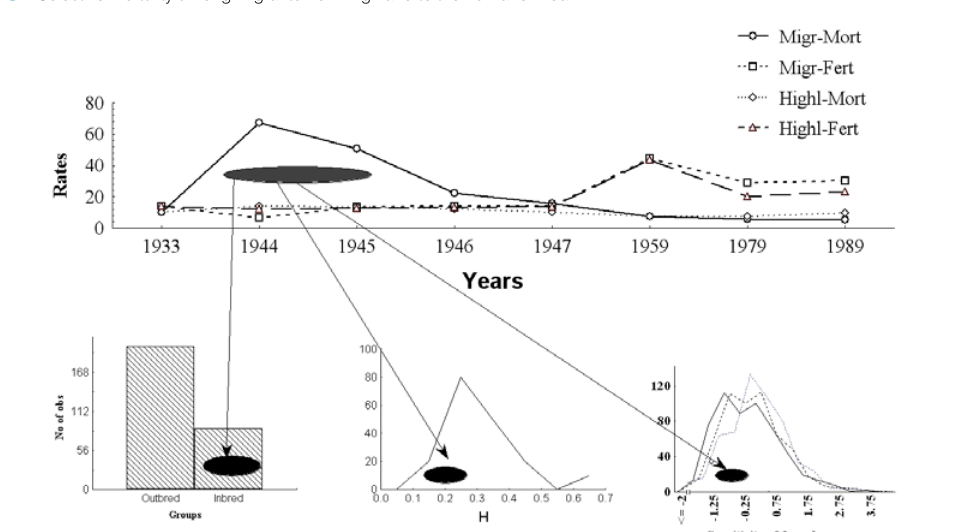
Figure 5. Selective Mortality among Migrants from Highland to the Lowland